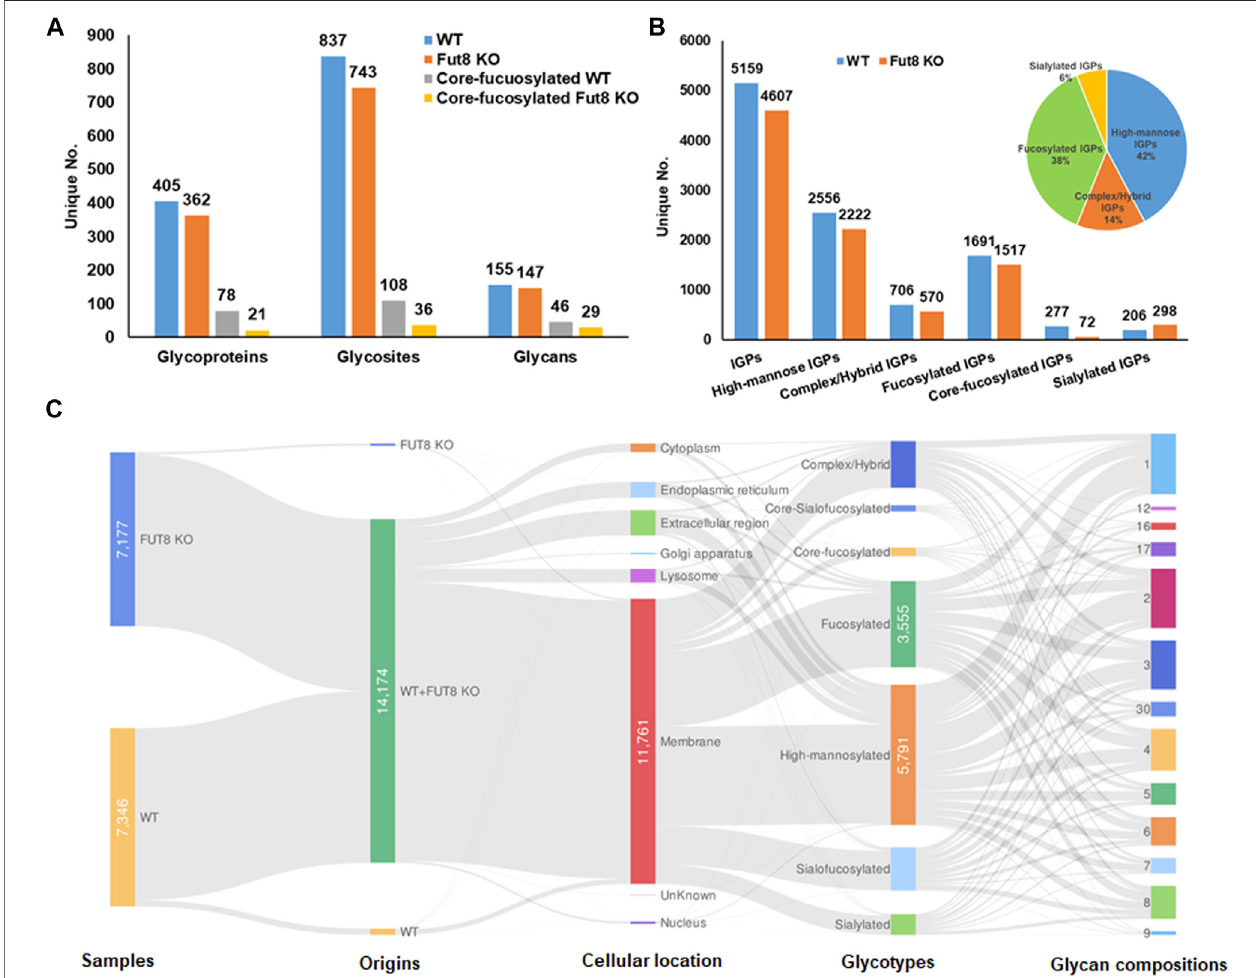
FIGURE 1 | Identi fi cation and distribution of glycoproteins in wild type (WT) and FUT8 Knock-out (KO) CHO-K1 cells. (A) Distribution of identi fi ed glycoproteins, glycosites and glycans in WT and FUT8KO CHO cells, (B) Identi fi cation of total and sub-glycotype IGPs identi fi ed from WT and FUT8KO CHO cells, showing that most IGPs are high-mannosylated both in WT and FUT8KO CHO-K1. (C) Illustration for distribution of protein glycotypes, cellular location and glycan compositions on the glycopeptides in WT and FUT8KO CHO cells.